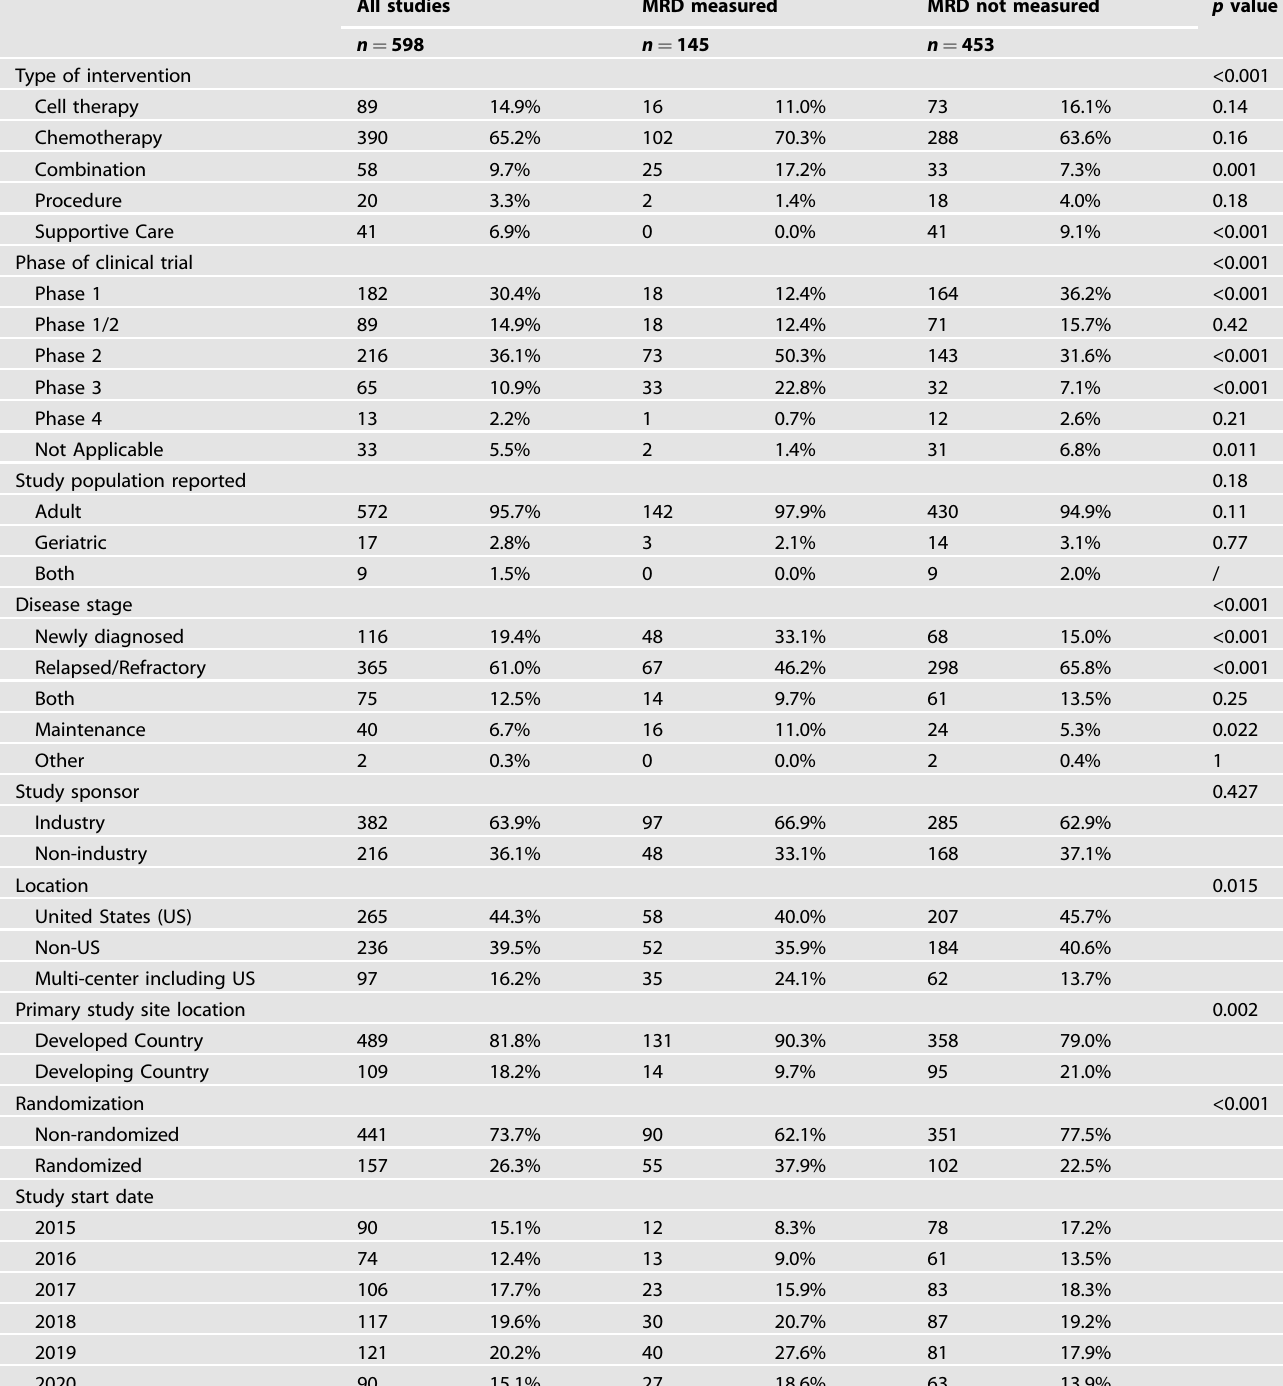
Table 1. Characteristics of all included study